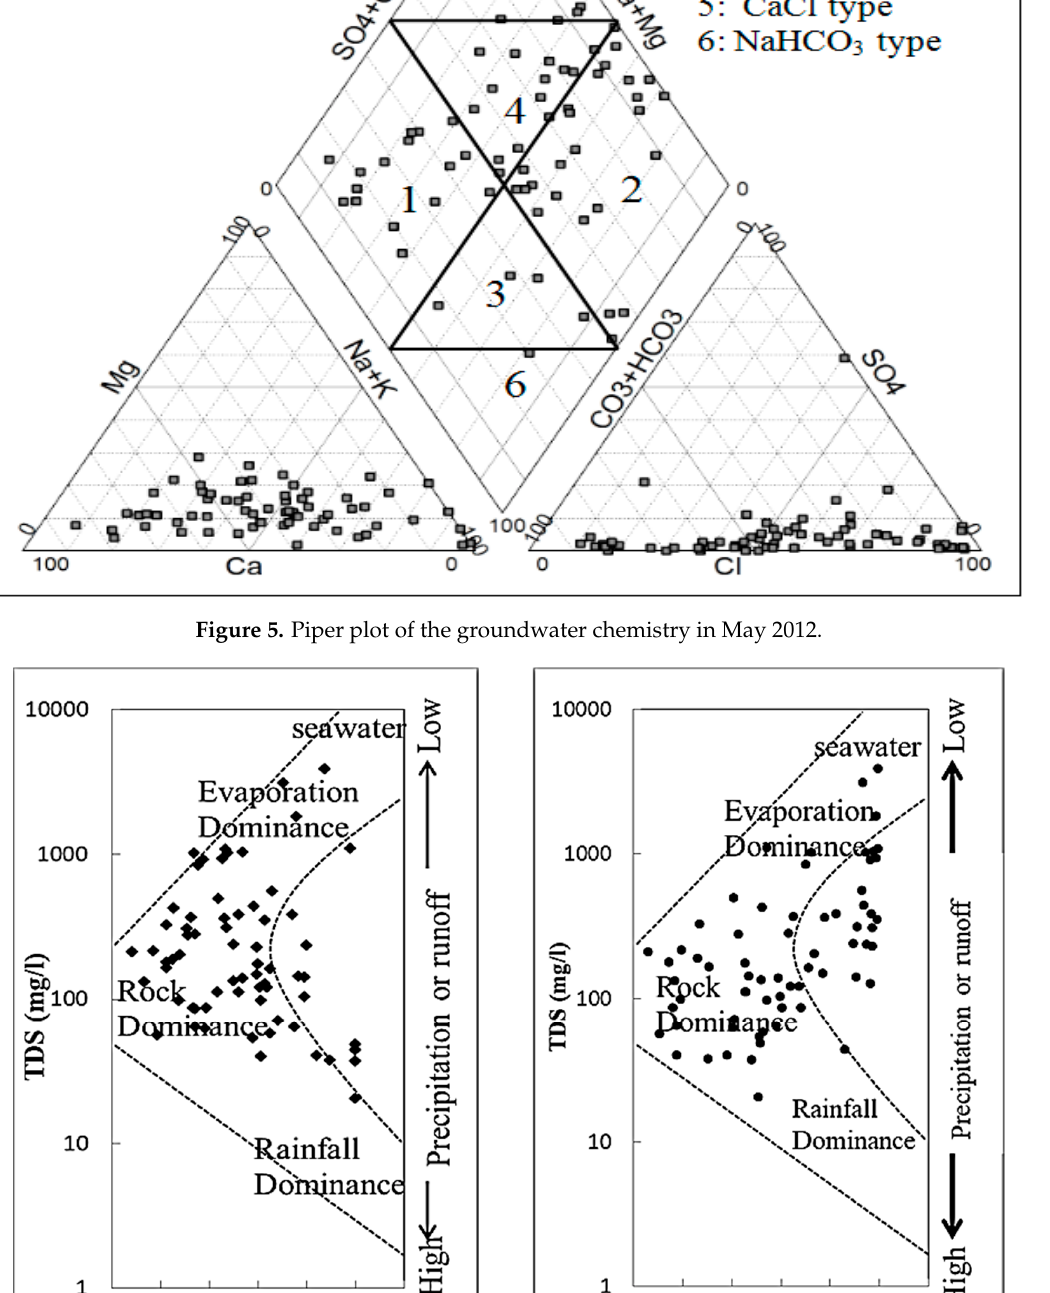
Figure 7. Chloro-Alkaline Indices ( a ) and Saturation Indices ( b ) of the groundwater samples. 3.2. Binary Diagram and Geochemical Process In this study, correlation analyses between various parameters of the groundwater have been calculated and are presented in Table 3. Correlation coefficient (R) is a commonly used measure to establish the relationship between two variables [43,44]. EC and TDS show a good positive correlation with Mg 2+ , Ca 2+ , Na + and Cl − (R > 0.82). A high positive correlation is found between Na + -Cl − (0.99), Mg 2+ -Cl − (0.90), Ca 2+ -Cl − (0.78) Ca 2+ -Na+ (0.72), and shows that for most of the groundwater samples these parameters originate from a common source.